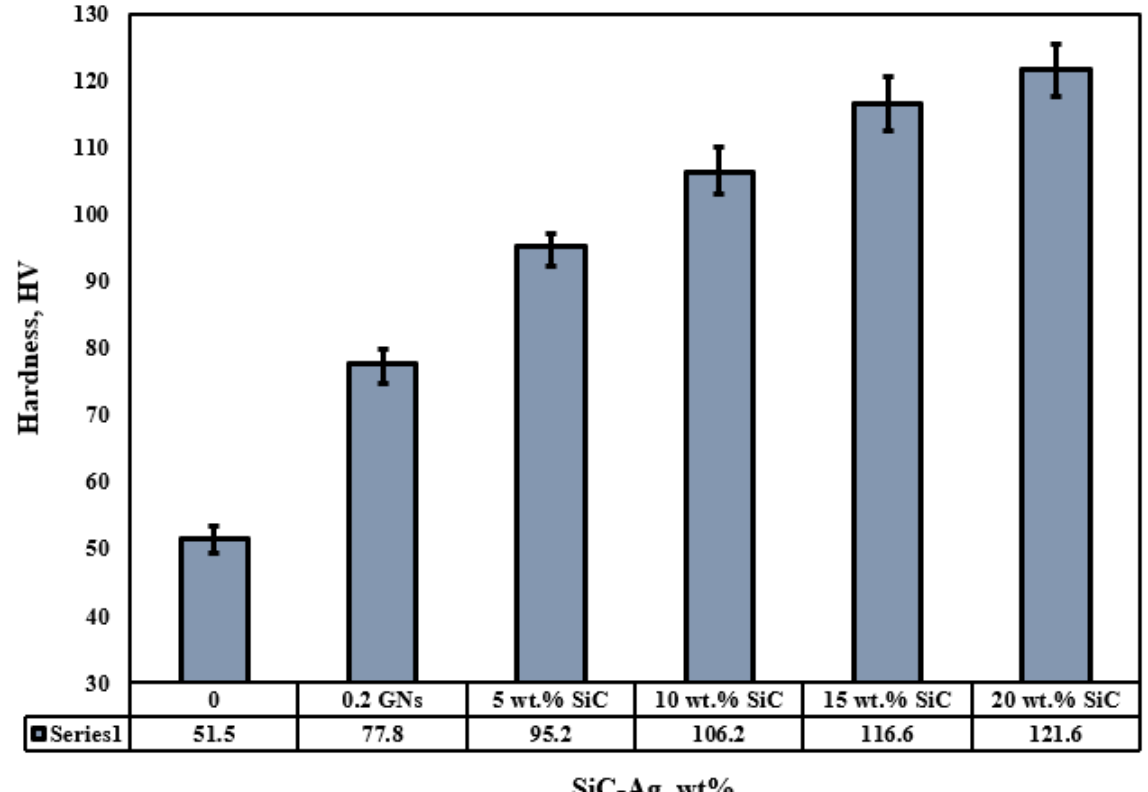
Figure 5. Hardness measurements of samples fabricated at 600 °C.